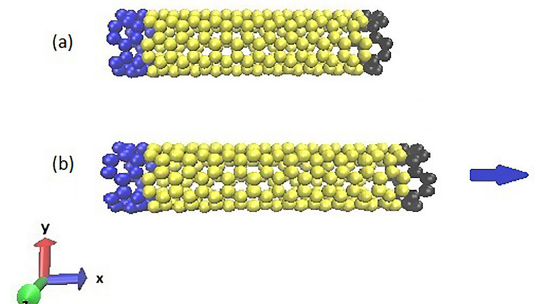
Figure 6. Schematic view of an armchair SWSiNT with C-F boundary conditions (a) relaxed and (b) after initial longitudinal exertion.